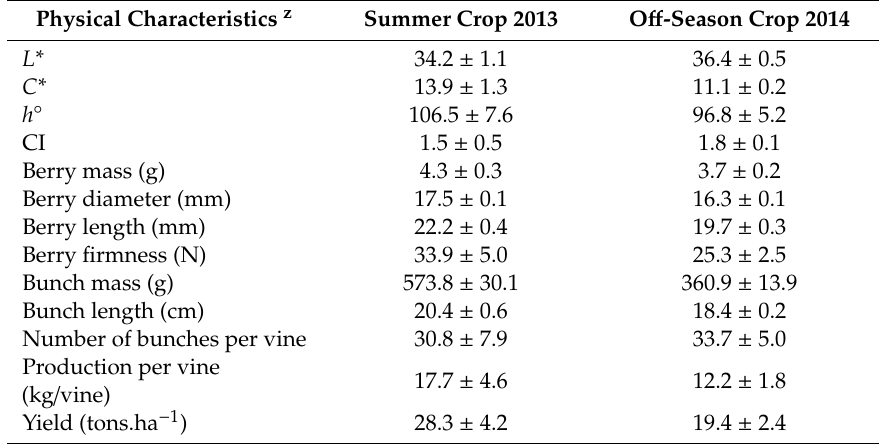
Table 2. Physical characteristics of ‘BRS Melodia’ seedless grape grown under an annual double cropping system in a subtropical region. Summer crop of 2013 and subsequent o ff -season crop of